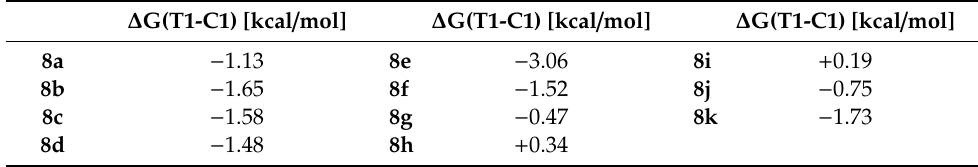
Table 2. Relative stability of diastereomer pairs 8 / T1 - 8 / C1 calculated by DFT modelling. ∆ G(T1-C1) [kcal /